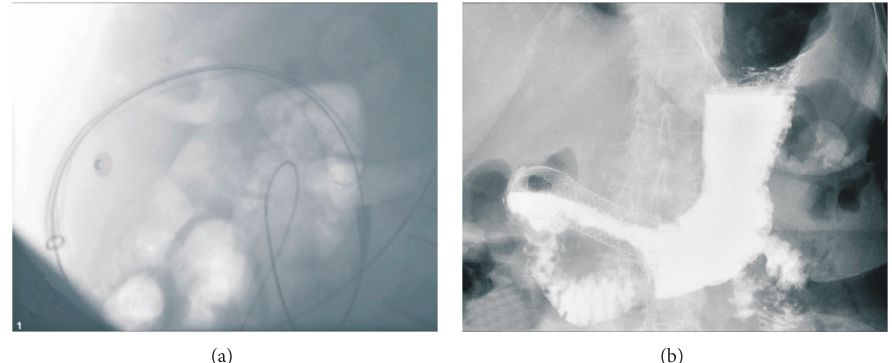
Figure 2: X-ray images of stents. (a) Image showing a stent released. (b) An example of barium contrast radiography of a funnel